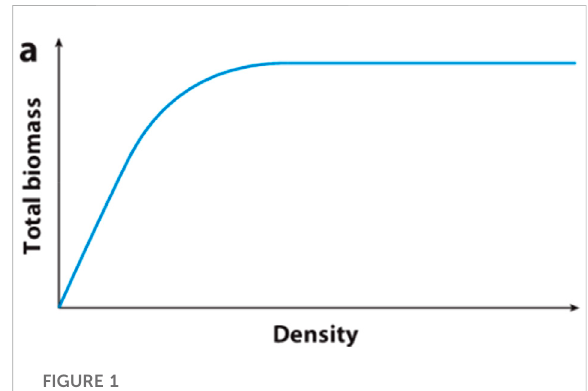
FIGURE 1 Graph showing the law of constant fi nal yield (Weiner and Freckleton,